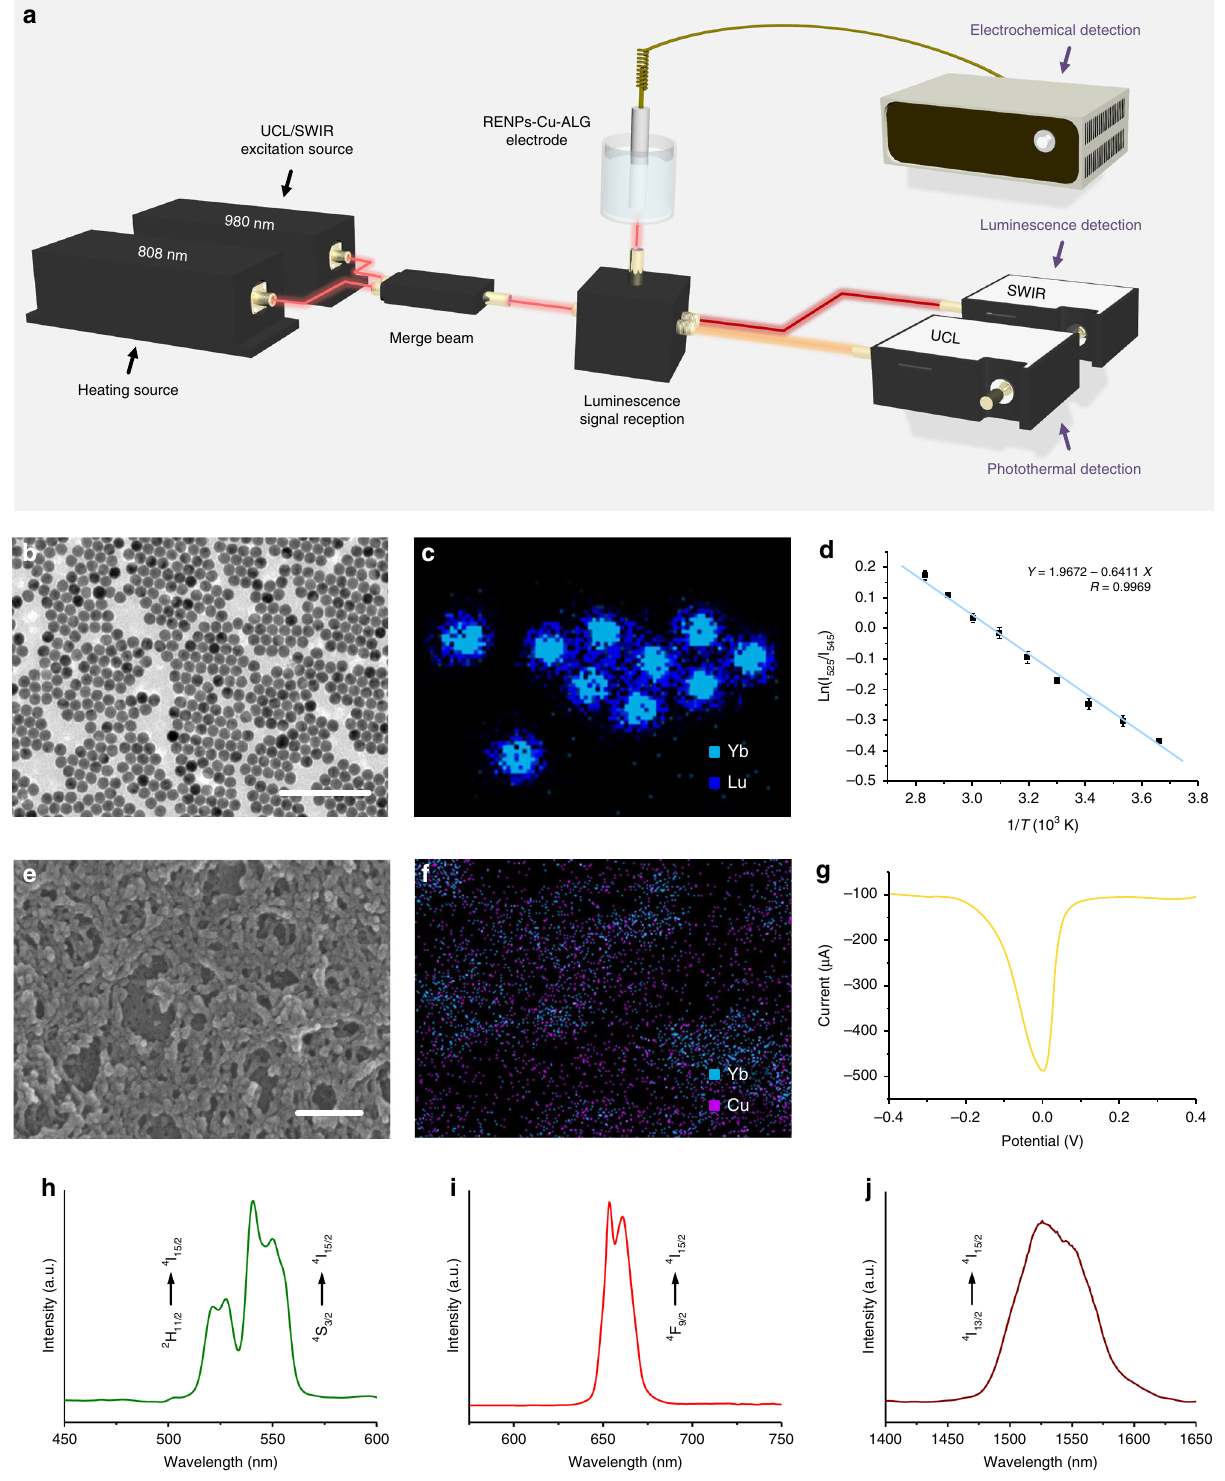
Fig. 1 Characterization of three-channel platform. a Schematic presentation of as-designed three-channel platform based on RENPs – Cu-ALG-gel-modi fi ed electrode. Transmission electron microscope image ( b ) and energy dispersive X-ray surface scan ( c ) of RENPs. d A plot of Ln(I 525 /I 545 ) versus 1/T to calibrate the thermometric scale for RENPs. Scanning electron microscope image ( e ) and energy dispersive X-ray surface scan ( f ) of three-channel platform. SWV curve ( g ), green UCL ( h ), red UCL ( i ), and SWIR luminescence ( j ) spectrum of three-channel platform. Scale bar, 200 nm. Data are represented as mean ± SD ( n =